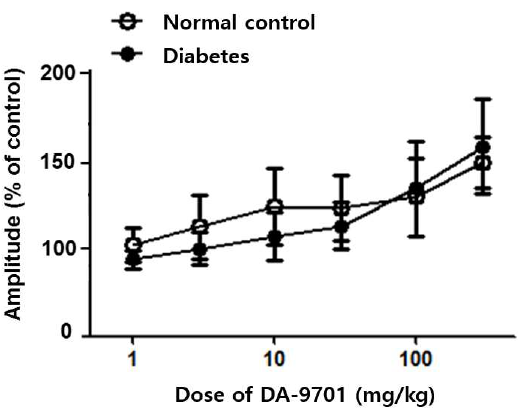
Figure 6. Effect of DA-9701 on antral motility in normal control and streptozotocin-induced diabetic mice. DA-9701 increased the spontaneous movement of the pyloric sinus ciliary muscle in a dose- dependent manner in both normal control and diabetic groups, without significant difference between two groups. (n = 10 in each group).